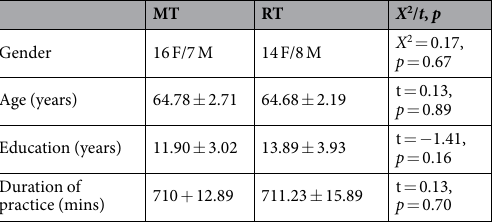
Table 1. Demographic characteristic of meditation practitioners and control subjects. Note: MT/RT, meditation training/relaxation training group; F/M,